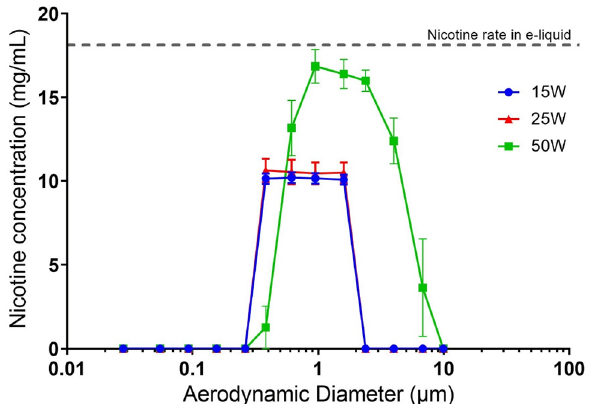
Figure 4. DLPI-collected data showing the effect of power level on the nicotine mass distribution. The results from using the 15 W, 25 W, and 50 W power levels are represented by a dot, triangle, and square, respectively. Experiments were carried out with an e-liquid composed of 50% propylene glycol and 50% vegetable glycerin with a nicotine concentration of 18 mg/mL (n = 5). DLPI DEKATI low pressure impactor, µm micrometers, mg/ mL milligrams per milliliter, W